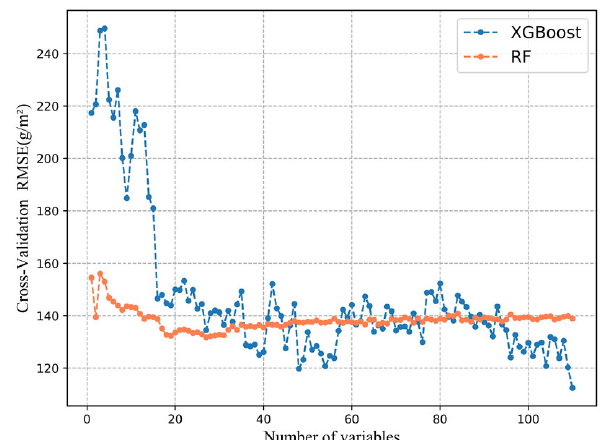
Figure 5. Optimization of a subset of predictor variables of the RF model based on the RMSE values after five-fold cross-validation.